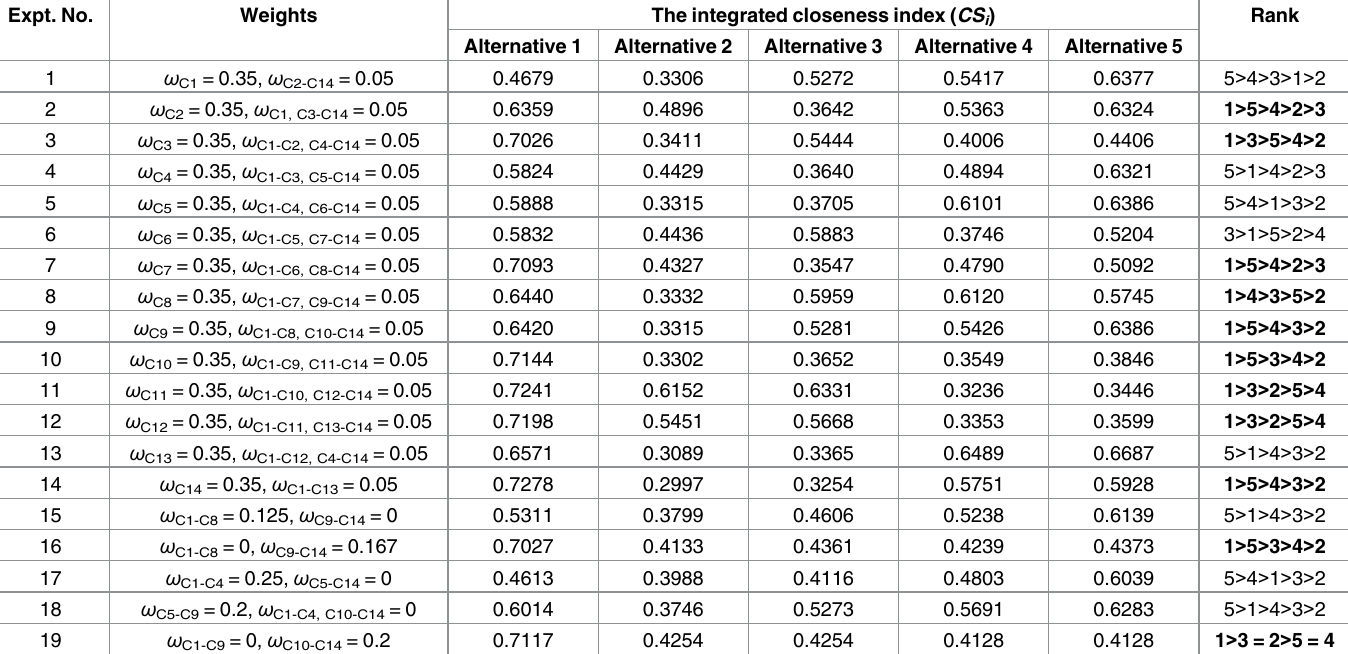
Table 9. The 19 experiments of sensitivity